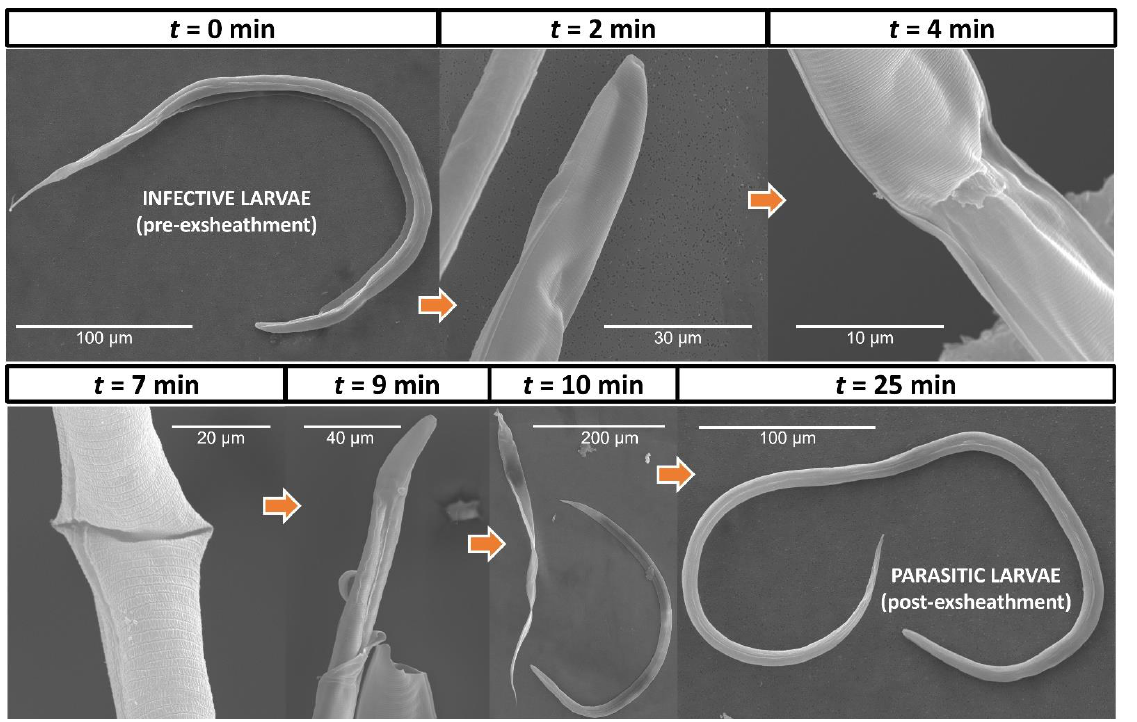
Figure 4. Scanning electron micrographs of the exsheathment process in H. contortus . SEMs are shown for seven time points post incubation ( t = 0, 2, 4, 7, 9, 10 and 25 min). Each image depicts the earliest observations of key morphological changes that occur during the exsheathment process and is representative of the larval population for each biological sample. Scale bars differ and have been adjusted according to magnification of each image.